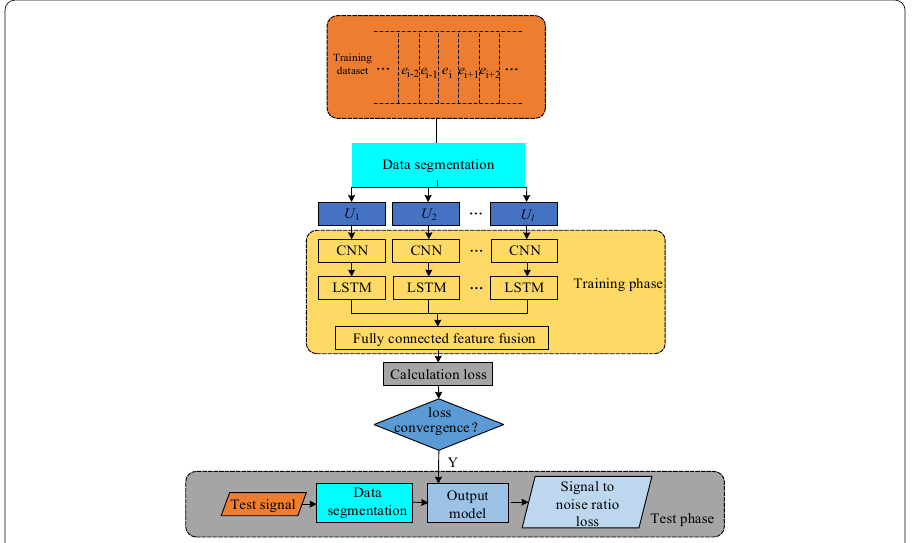
Fig. 2 Flowchart of the CNN-LSTM